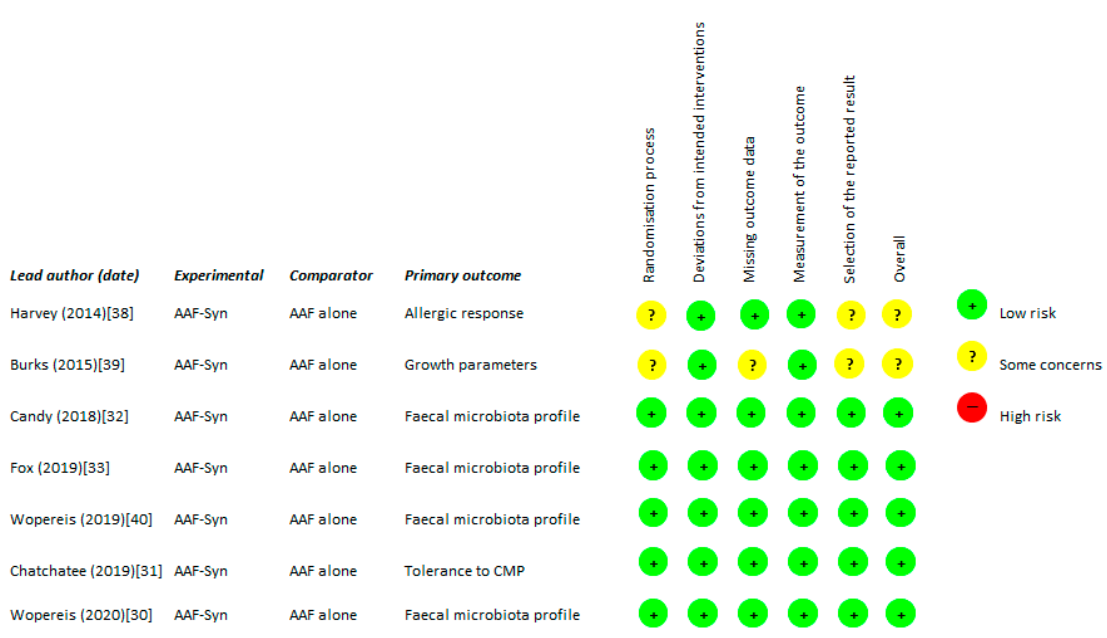
Figure 2. Results of risk of bias assessment for the seven included publications (ROB-2 [29]). Abbreviations: AAF-Syn: amino acid formula with synbiotics. AAF: amino acid formula. CMP: cow’s milk protein.